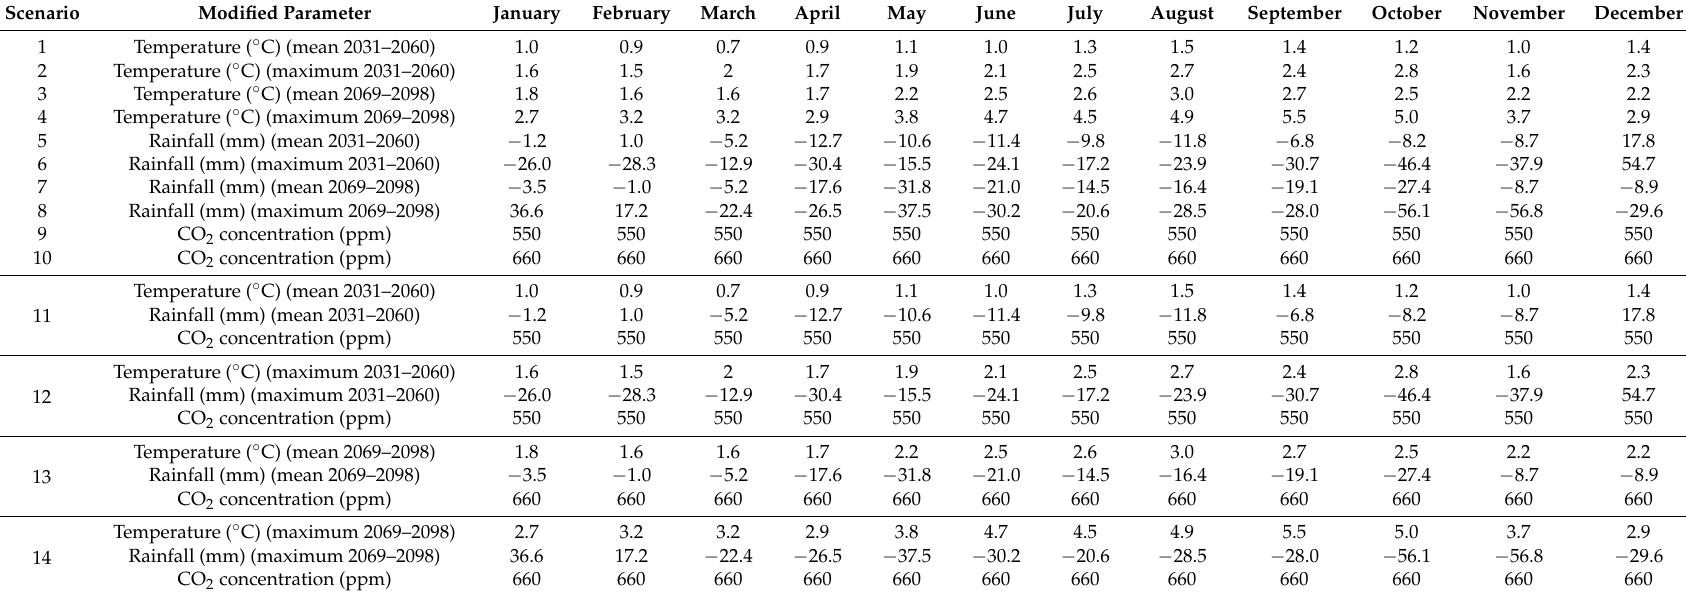
Table 1. Climate change scenarios used for SWAT (Soil and Water Assesment Tool)